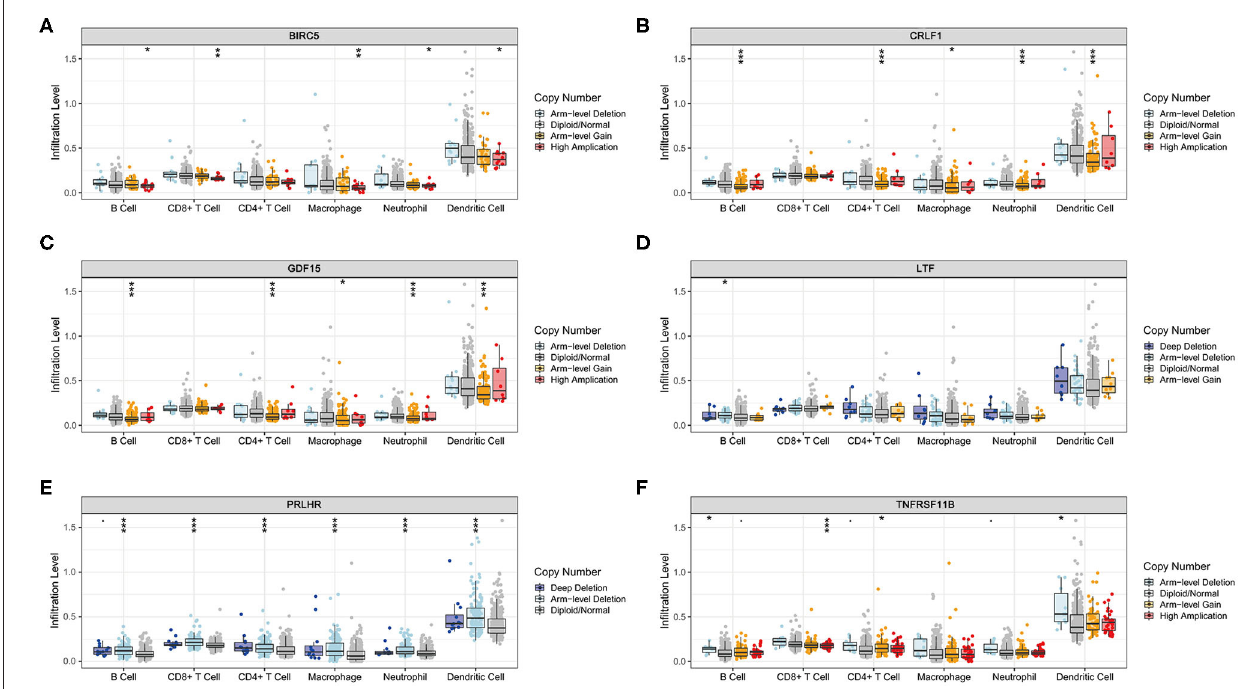
FIGURE 4 | Immune cell infiltration levels of the six hub TMB-related gene mutants. (A) BIRC5, (B) CRLF1, (C) GDF15, (D) LTF, (E) PRLHR, (F) TNFRSF11B. * p < 0.05, ** p < 0.01, and *** p < 0.001.